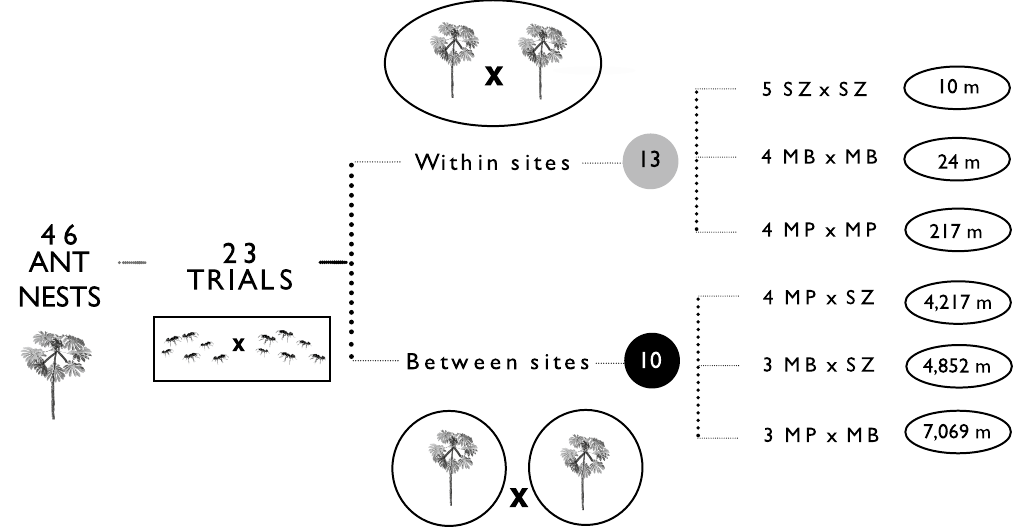
Figure 1. Schematic representation of behavioral trials showing the number of ant nests (trees) and trials within and between the three sampling sites. The number within circles represent the average spatial distance between ant nests (trees) that were engaged in behavioral trials from the six possible combinations of sites. Within sites—MP versus MP; SZ versus SZ; MB versus MB and between sites: MP versus MB; MP versus SZ; MB versus SZ. SZ—“Seu zé”; MB—“Mata da Biologia” and MP—“Mata do